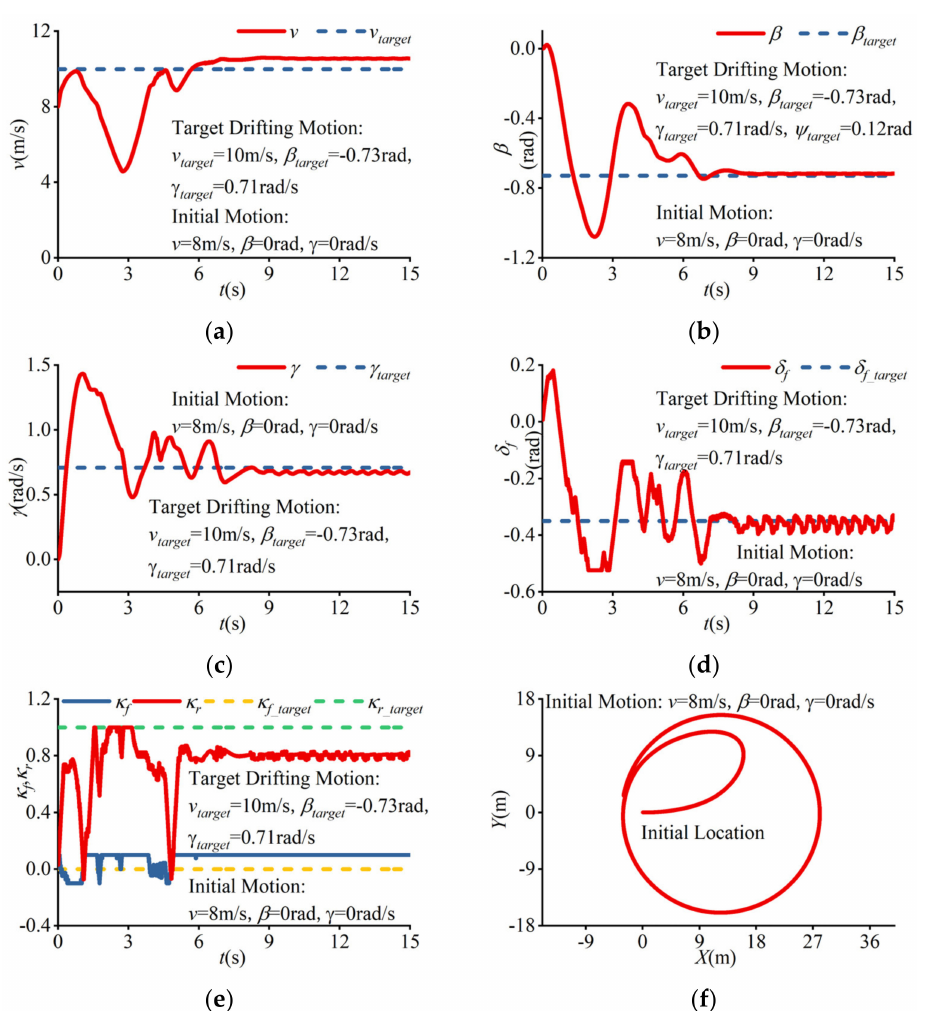
Figure 8. The simulation result with the initial motion as Group 2 in Table 3 to realize the target drifting motion as Group 2 in Table 2: ( a ) the variation curve of the velocity; ( b ) the variation cure of the sideslip angle; ( c ) the variation curve of the yaw rate; ( d ) the variation cure of the steering angle; ( e ) the variation curves of the TYDEX longitudinal slip ratios; ( f ) the position modification of the narrow tilting vehicle in the ground coordinates.